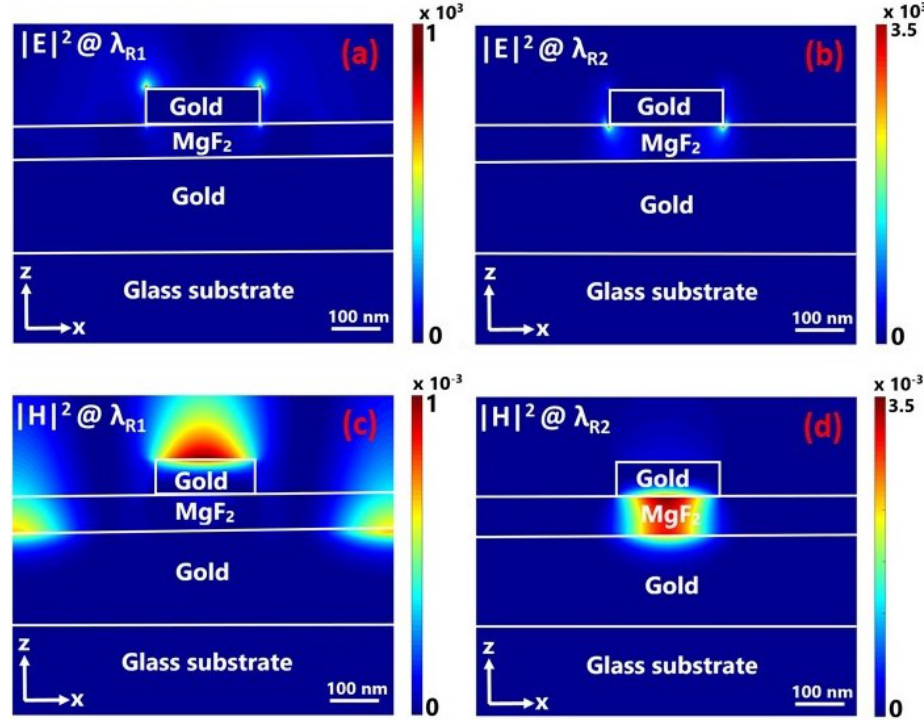
Figure 2. Cross-sectional view of the simulated electric field intensity | E | 2 and magnetic field intensity | H | 2 at resonant wavelengths of λ = 653 nm ( a , c ) and λ = 865 nm ( b , d ), respectively. Electric field R 2 R 1 intensity at both resonant wavelengths is enhanced by a factor of up to 10 3 , around the edges of the nanodisc. This confirms that the first resonant mode is excited with incident light coupling into the propagating surface plasmons (PSPs) on the gold film. On the other hand the second resonant mode is a fundamental